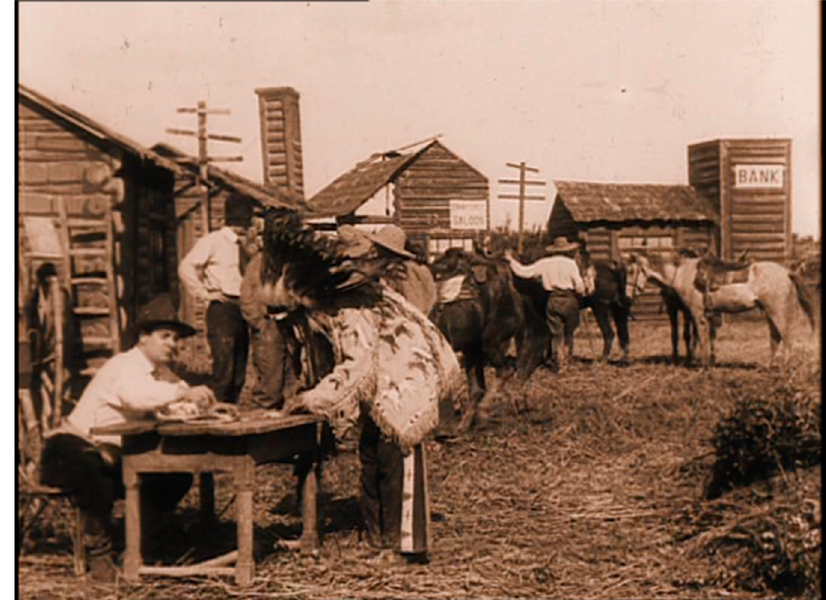
Figure 20. Jean Durand, Still from Gaumont Cinema, Prairie en Feu, 1912. Photograph taken by the author.